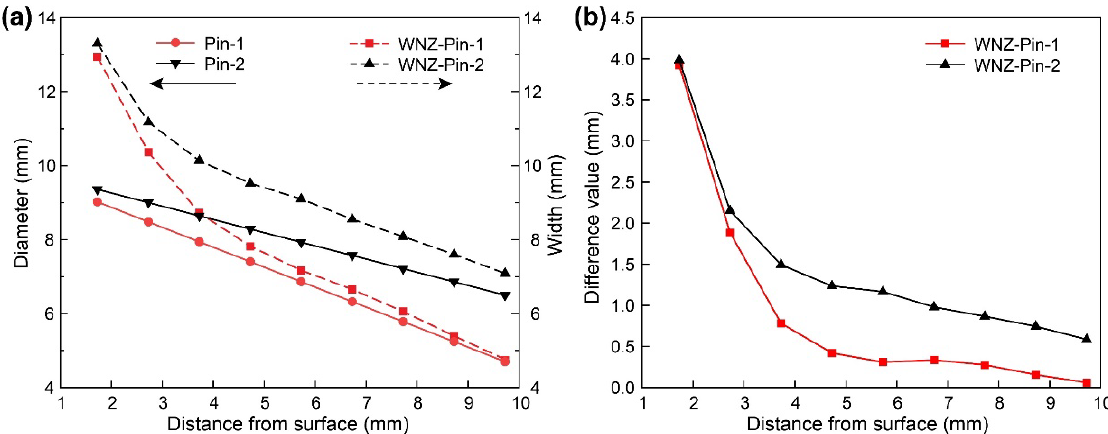
Figure 9. ( a ) Pin diameter and WNZ width and ( b ) difference value between pins and WNZ.